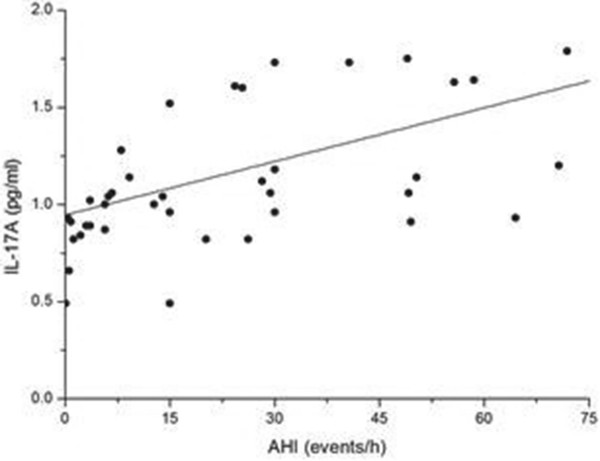
The relationship between AHI and IL-17A level. There was a significant positive relationship between AHI and the IL-17A level (r = 0.520, p < 0.01).